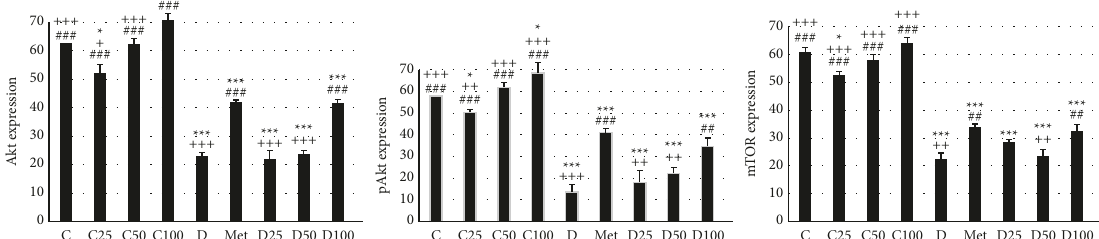
Figure 5: The expression of Akt, pAkt (phospho-Akt), and mTOR protein. ∗ Statistically different from the control rats ( p < 0 . 05), ∗∗∗ statistically different from the control rats ( p < 0 . 001), ## statistically different from the sham rats ( p < 0 . 01), ### statistically different from the sham rats ( p < 0 . 001), + statistically different from the Met rats ( p < 0 . 05), ++ statistically different from the Met rats ( p < 0 . 01), +++ statistically different from the Met rats ( p < 0 . 001). C: control rats, D: the sham or diabetic rats, MET: diabetic rats+metformin (55mg/kg), C25: control rats+p-cymene (25mg/kg), C50: control rats+p-cymene (50mg/kg), C100: control rats+p-cymene (100mg/kg), D25: diabetic rats+p- cymene (25mg/kg), D50: diabetic rats+p-cymene (50mg/kg), and D100: diabetic rats+p-cymene